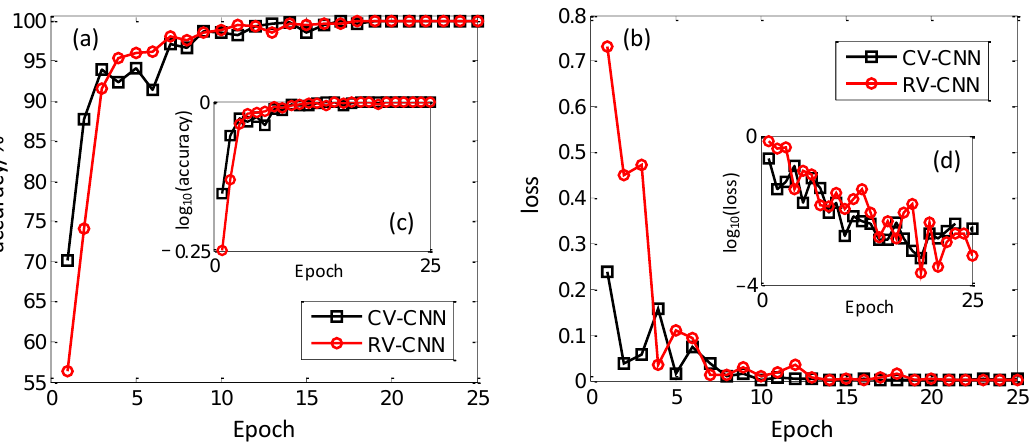
Figure 5. Training results of CV-CNN and RV-CNN on training set. ( a ) Training accuracy, ( b ) Train-